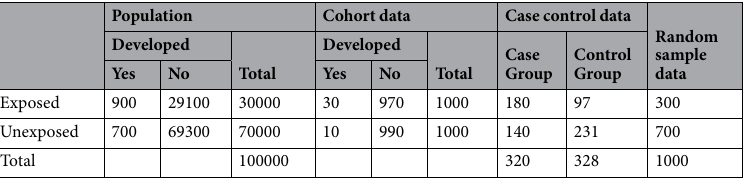
Table 2. Model data: population, cohort, case control, and census data. This city, which has a population of 100000, and 30000 individuals exposed to X, includes 900 exposed and 700 unexposed patients who developed Y. Accordingly, 30 and 10 patients should be found when 1000 exposed and 1000 unexposed participants have been observed as cohorts; 180 patients and 97 participants should have been exposed when a case group of 320 and a control group of 328 are observed; and 300 exposed people should be found when 1000 individuals are randomly